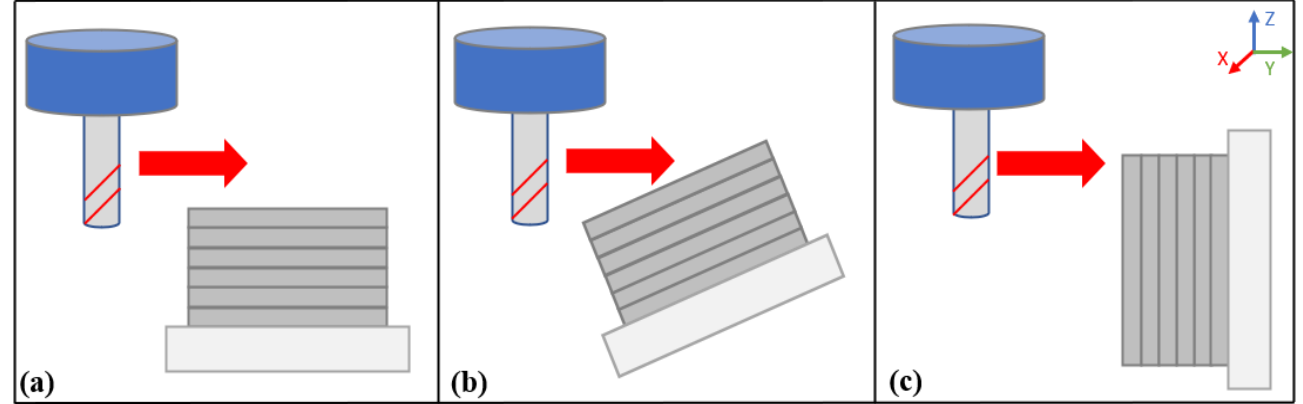
Figure 2. Tool posture representation—( a ) 0 degrees, ( b ) 35 degrees, ( c ) 90 degrees.